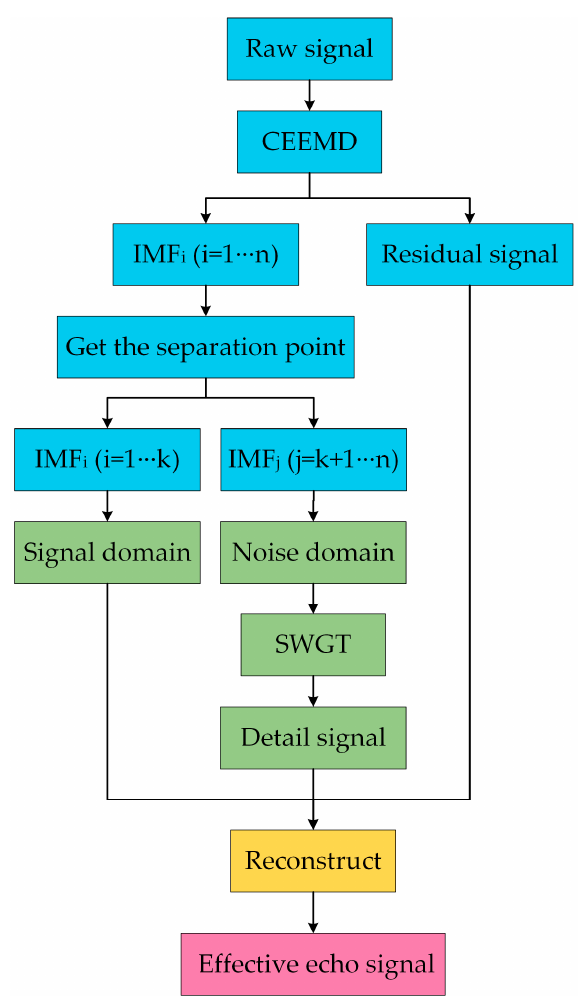
Figure 4. The details of obtaining an effective echo signal.